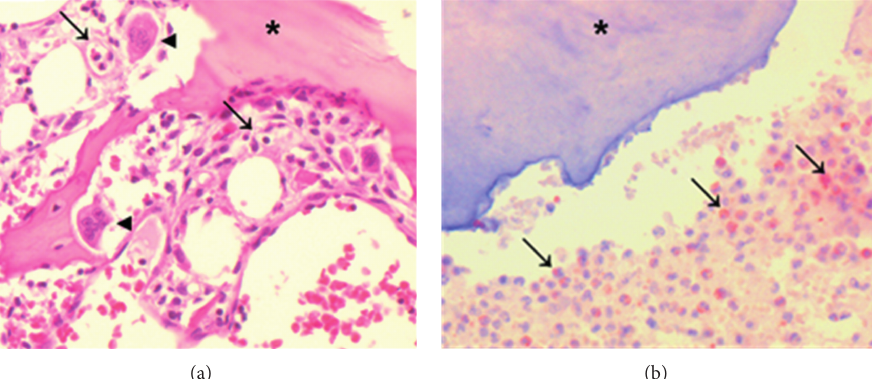
Figure2:Biopsyofapatientwithinfectionandmassiveosteolysis:(a)HEstainingshowsdegradedbone(star)andosteoclasts(arrowhead)in the immediate vicinity. Moreover, neutrophils and mononuclear cells are seen (arrows). (b) Specific staining for CCL3 indicated by brownish coloring is mostly associated with mononuclear cells